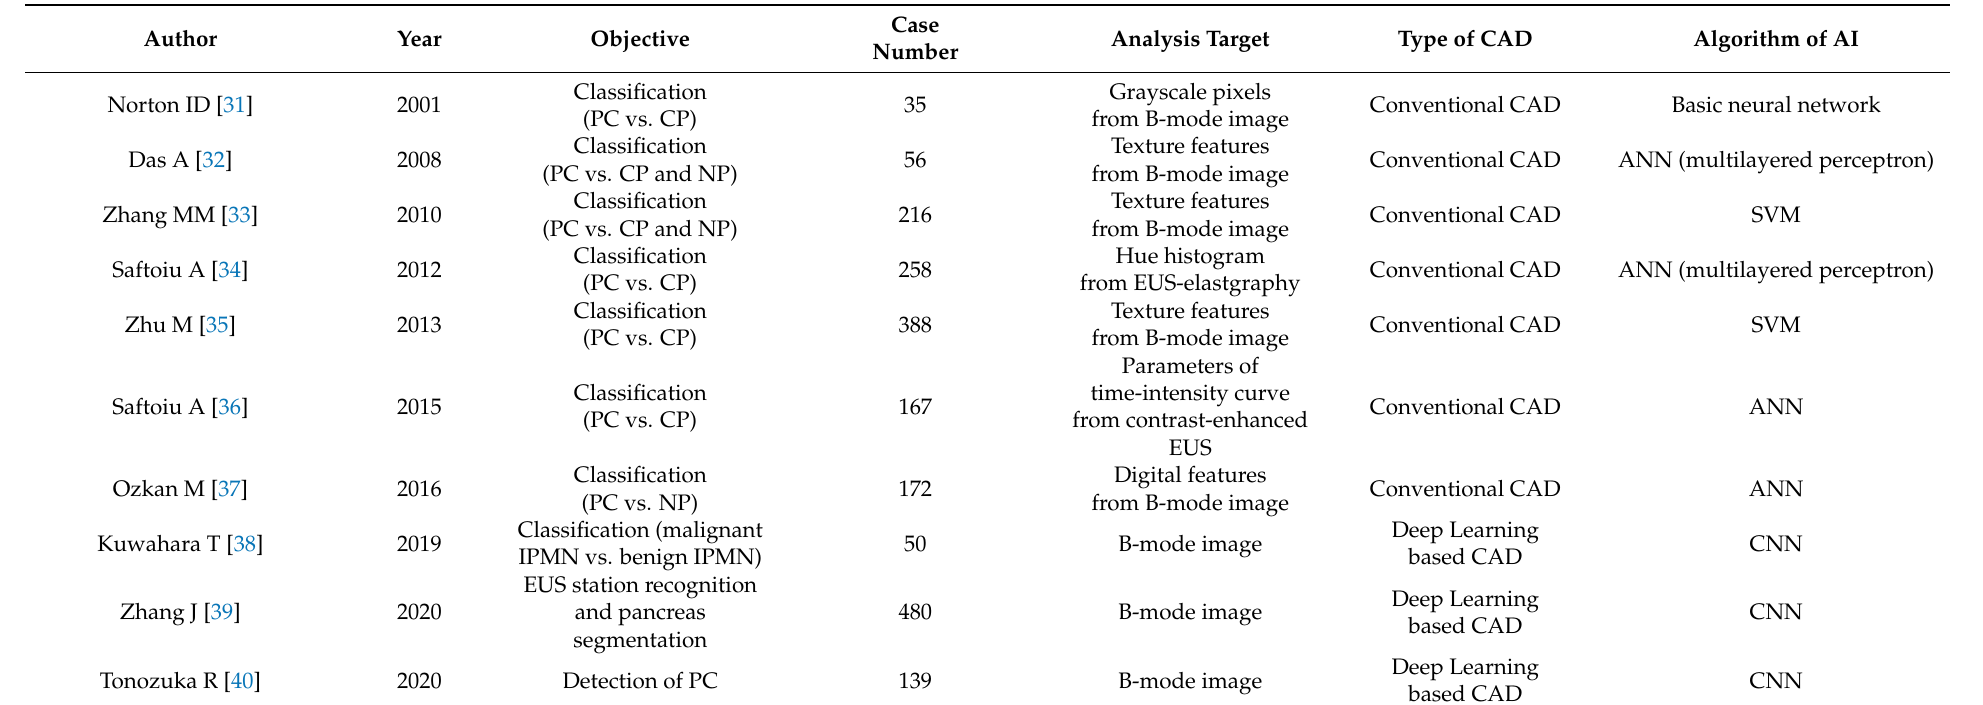
Table 1. Summary of reviewed published studies using artificial intelligence to analyze pancreatic endoscopic ultrasound (EUS)